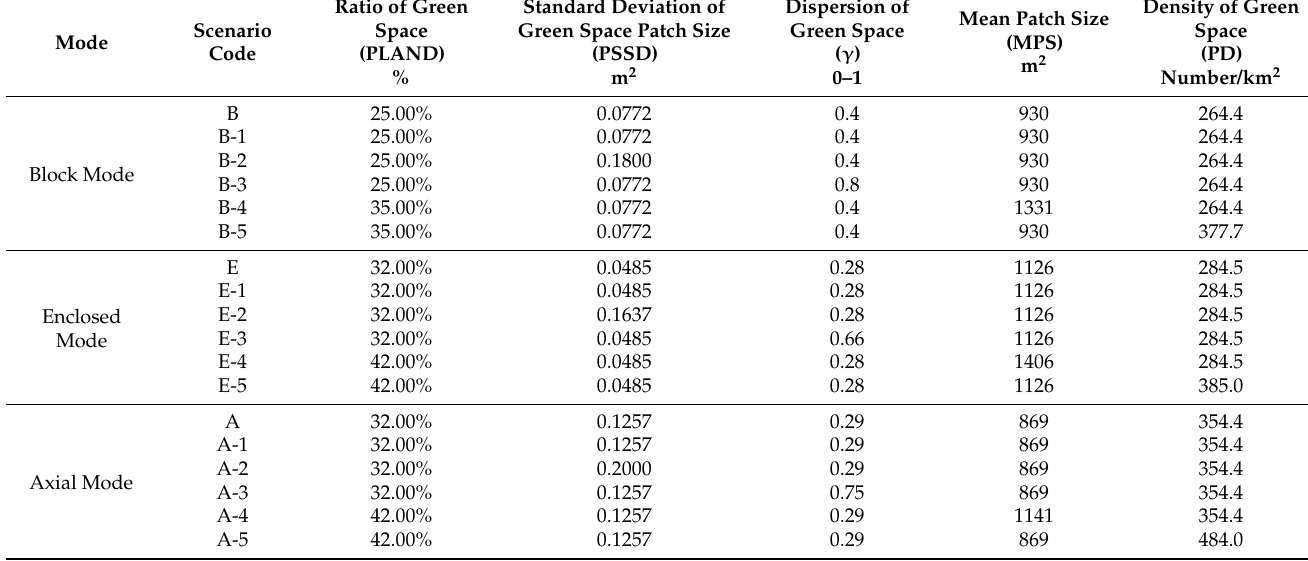
Table 3. Distribution characteristics for 3 basic modes and 15 “what-if”